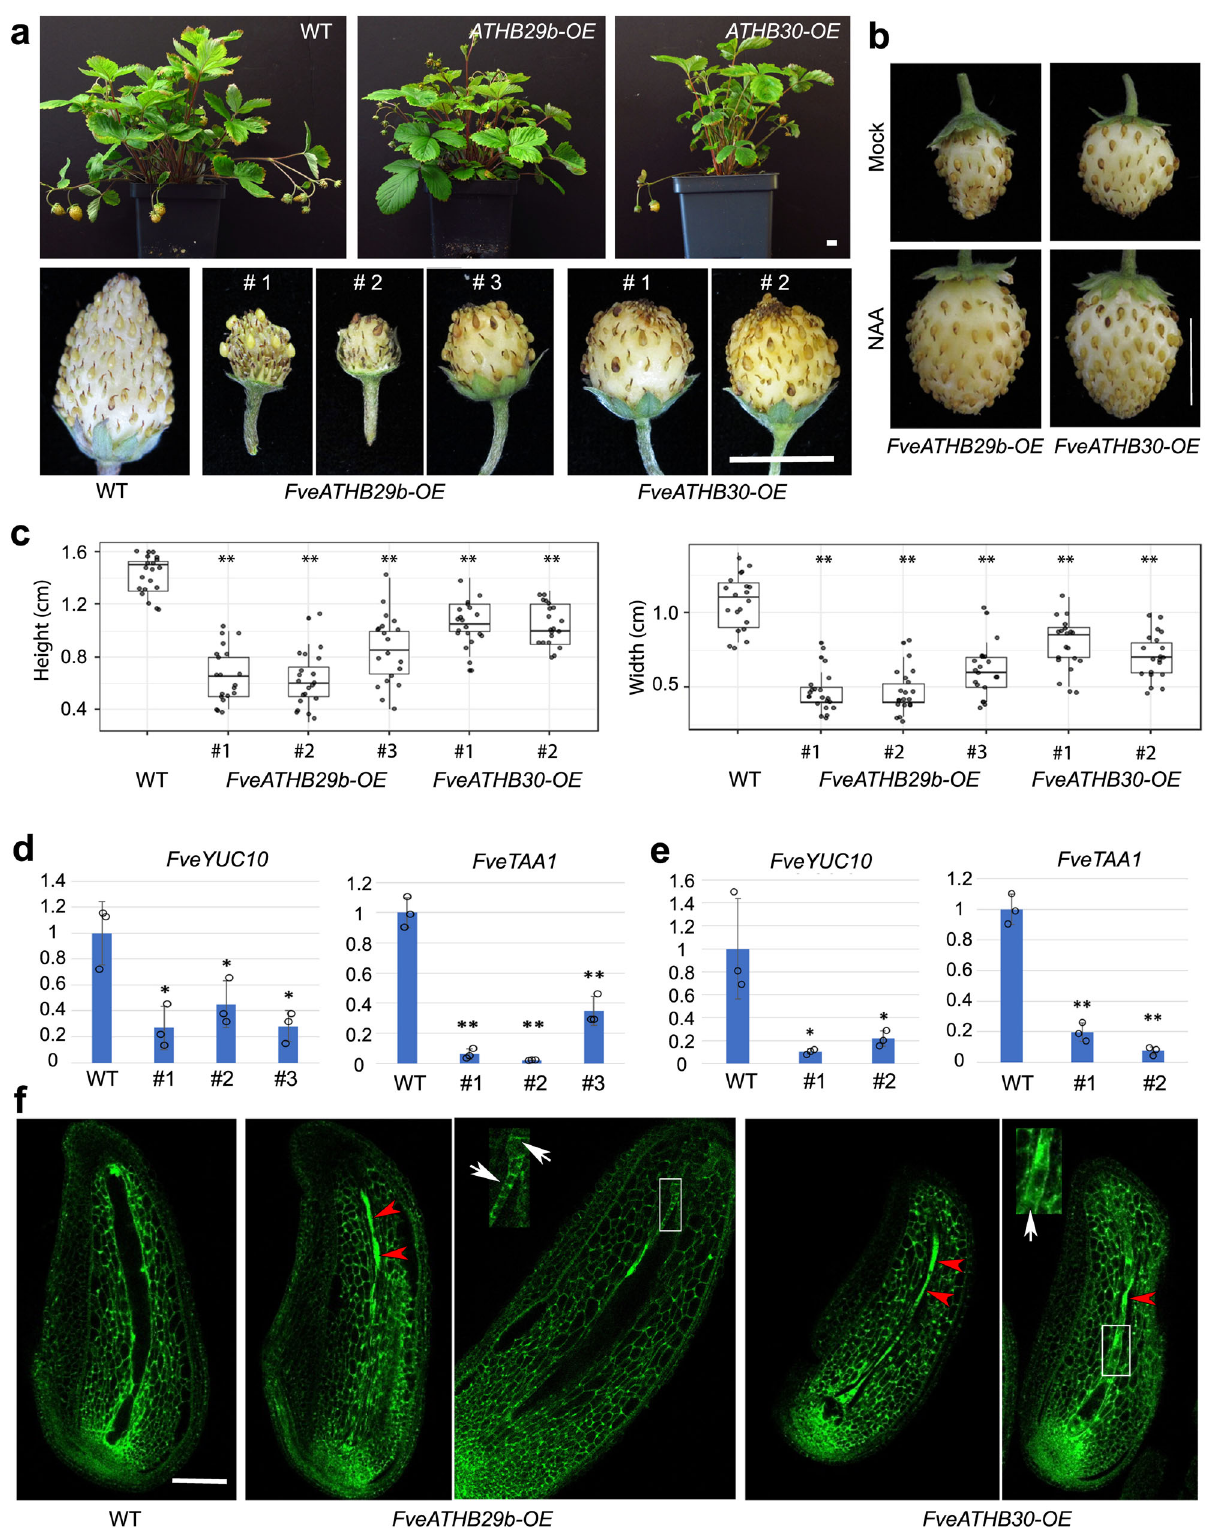
wild strawberry F. vesca showed that the fertilization-induced auxin biosynthesis mainly occured in the endosperm 5,12 . How- ever, the molecular mechanism underlying this fertilization- induced auxin biosynthesis in the endosperm is unknown. In this study, we show that the type I MADS-box gene FveAGL62 is required for auxin biosynthesis in the endosperm and FveAGL62